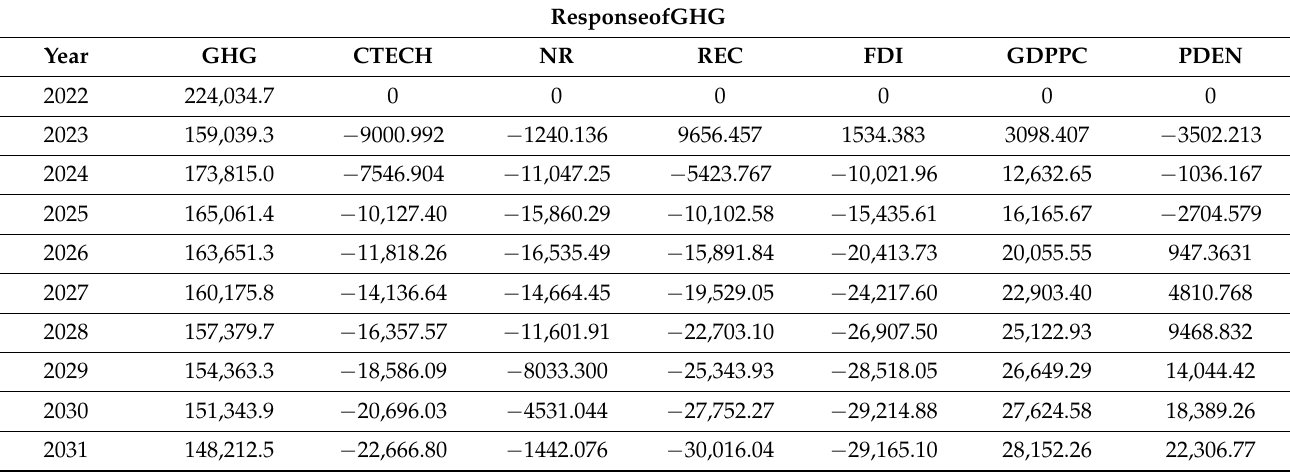
Table 7. IRF Predictions.